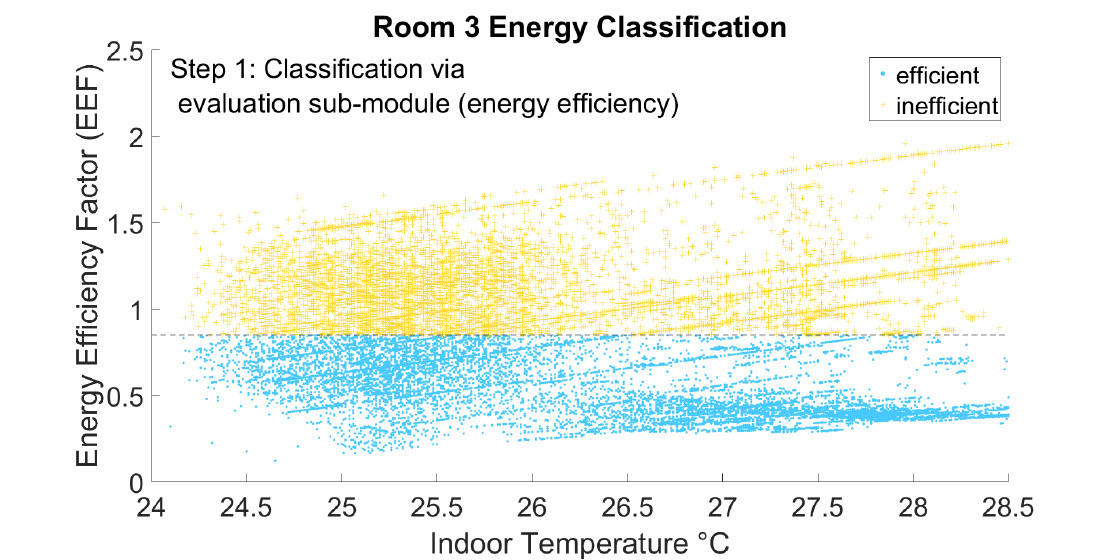
Figure 5. Classification of energy-efficient and energy-inefficient behavior based on inference rules in the evaluation sub-module for